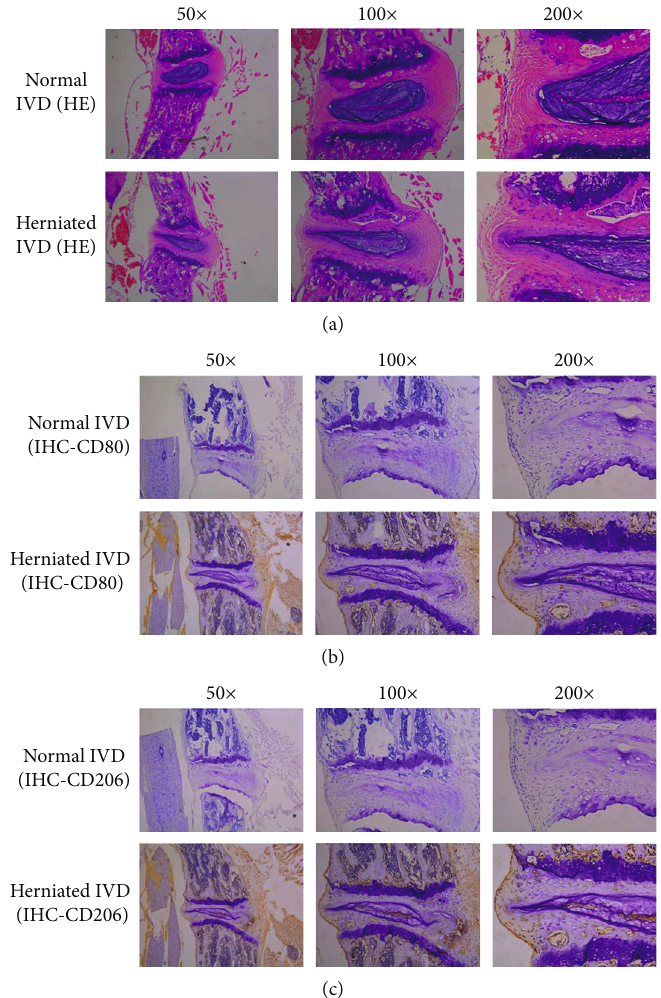
Figure 4: H&E staining showed that the IVD in mouse models herniated into the spinal canal. In comparison with the normal IVD, it was clear that the height of IVD space became narrow, the shape of NP tissue became sharp, the annulus fi brosus became thinned and damaged, and the extracellular matrix was also degenerate in the mouse models. These changes altogether indicated that the IVD was severely degenerated in mouse models (a). IHC staining showed that measurable amounts of CD80+M1 and CD206+M2 macrophages (brown color) in fi ltrated in herniated IVDs, while no macrophages presented in normal IVD (b, c). Further we found that these in fi ltrated macrophages (brown color) mainly distributed in the outer layer of annulus fi brosus, and the inner degenerated NP tissue (b,